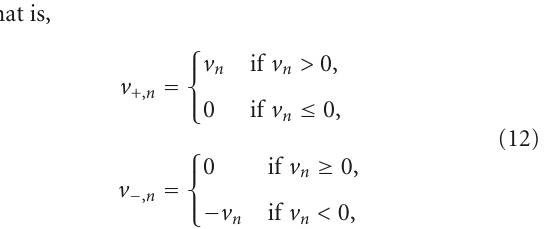
transmitter results in a single carrier transmission instead of multicarrier and hence reduction of the PAPR as shown in Figure